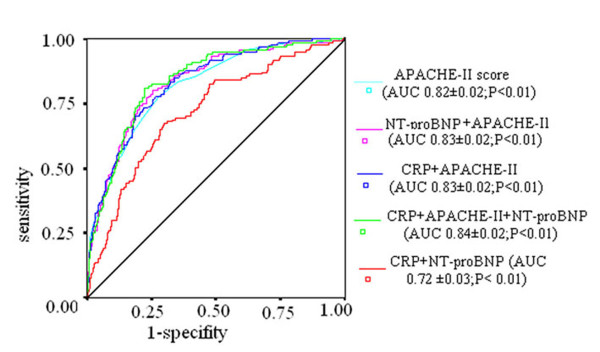
ROC curves for combination of two or three variables among CRP, NT-proBNP and APACHE-II score. Combination of CRP or NT-proBNP or both with APACHE-II score did not significantly increase AUC with regard to perdition of ICU mortality (all P > 0.05). Combination of CRP and NT-proBNP was inferior to APACHE-II score alone for predicting ICU mortality (P < 0.01).